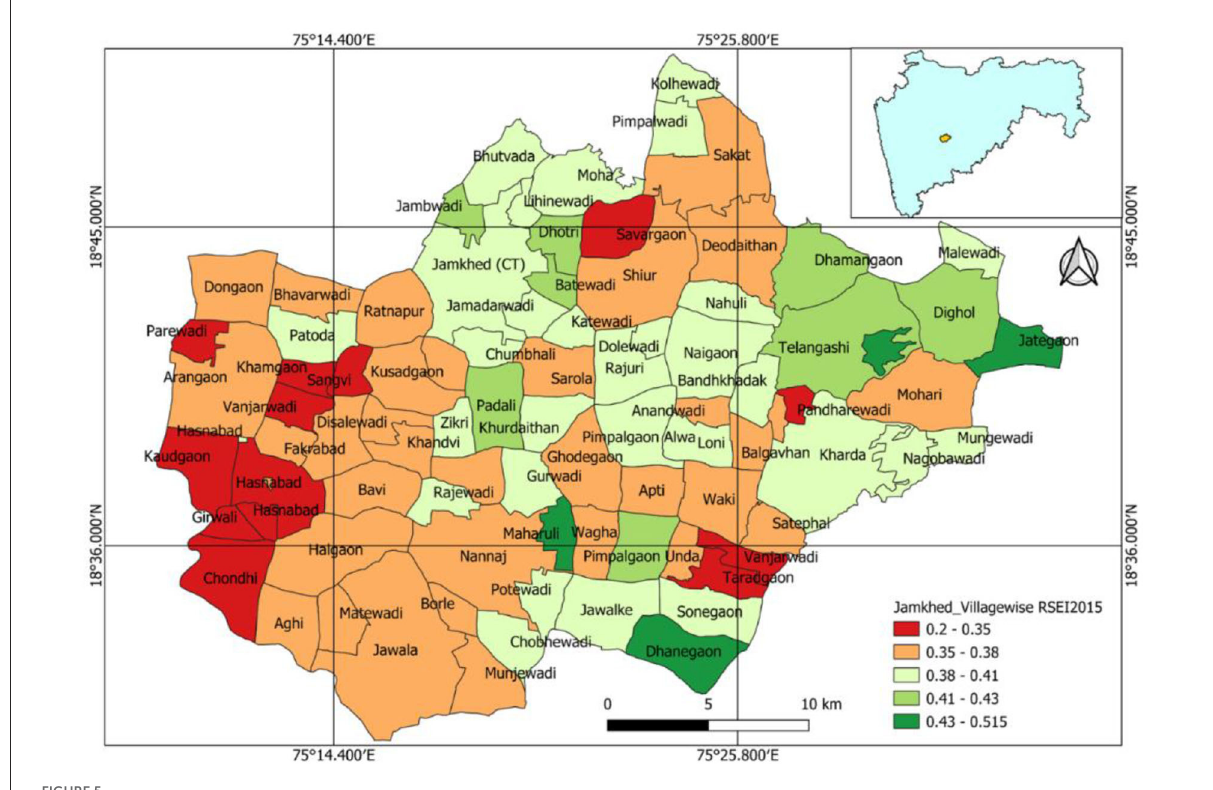
FIGURE5 Village-wise RSEI of Jamkhed taluka for the year